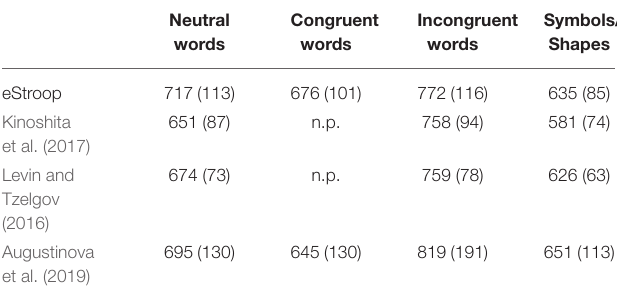
TABLE 2 | Means RT (standard deviations) of our study and the other study we compared.